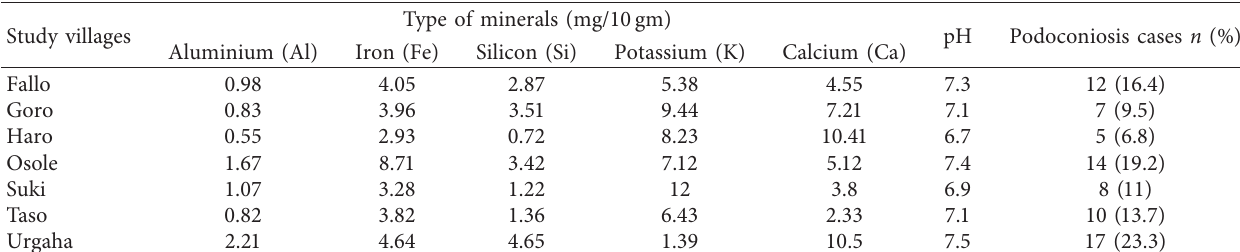
Table 6: Soil mineral types of the study villages in Jeldu district, West Shoa, Ethiopia. Study villages